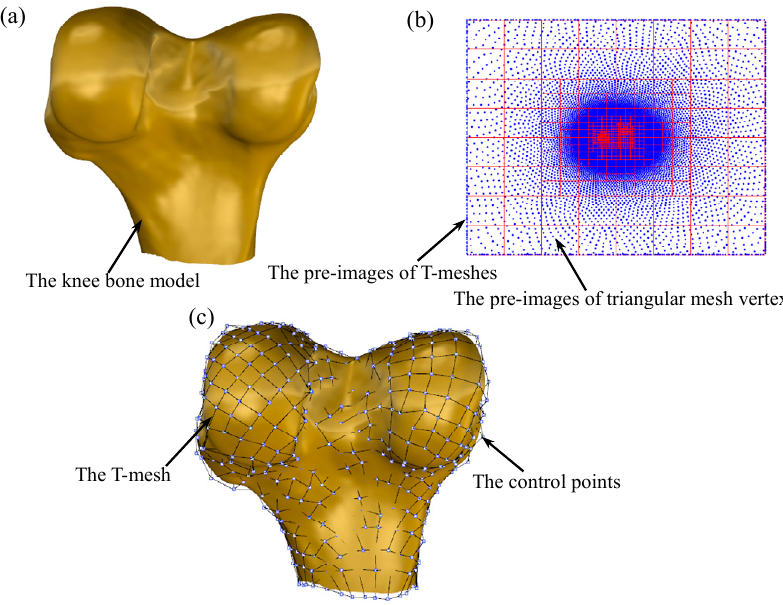
Figure 6. The actual experiment equipment includes coordinate measuring machine, measured workpiece and visual system, ( a ) the overall physical diagram, ( b ) the partial magnification of probe and visual system.